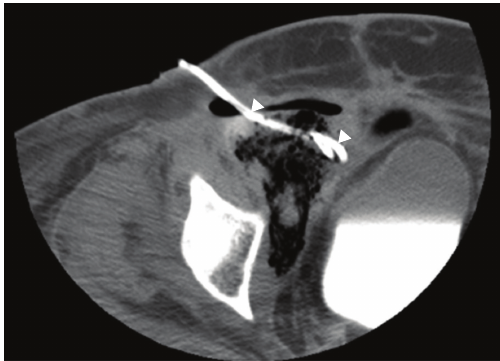
Figure 2: Noncontrast CT image following percutaneous drainage shows 12 French catheter (arrowheads) in anterior aspect of pelvic